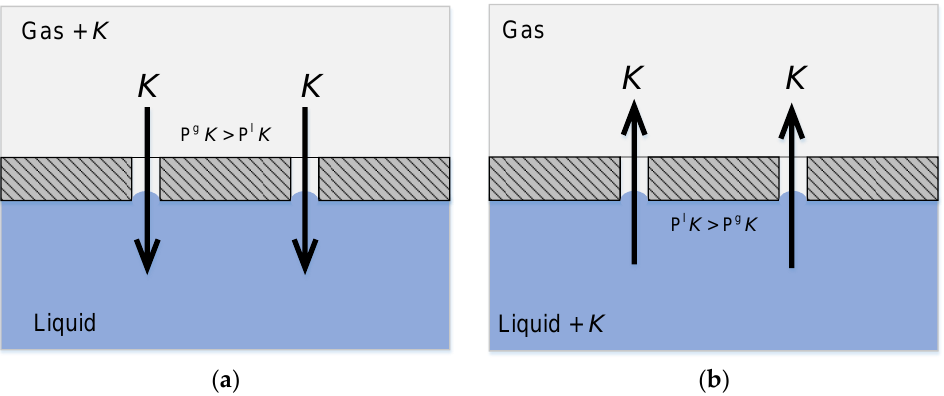
Figure 4. Principle of mass transfer in a membrane contactor: ( a ) Absorption of a component from the gaseous phase; and, ( b ) Desorption of a component from the liquid phase.